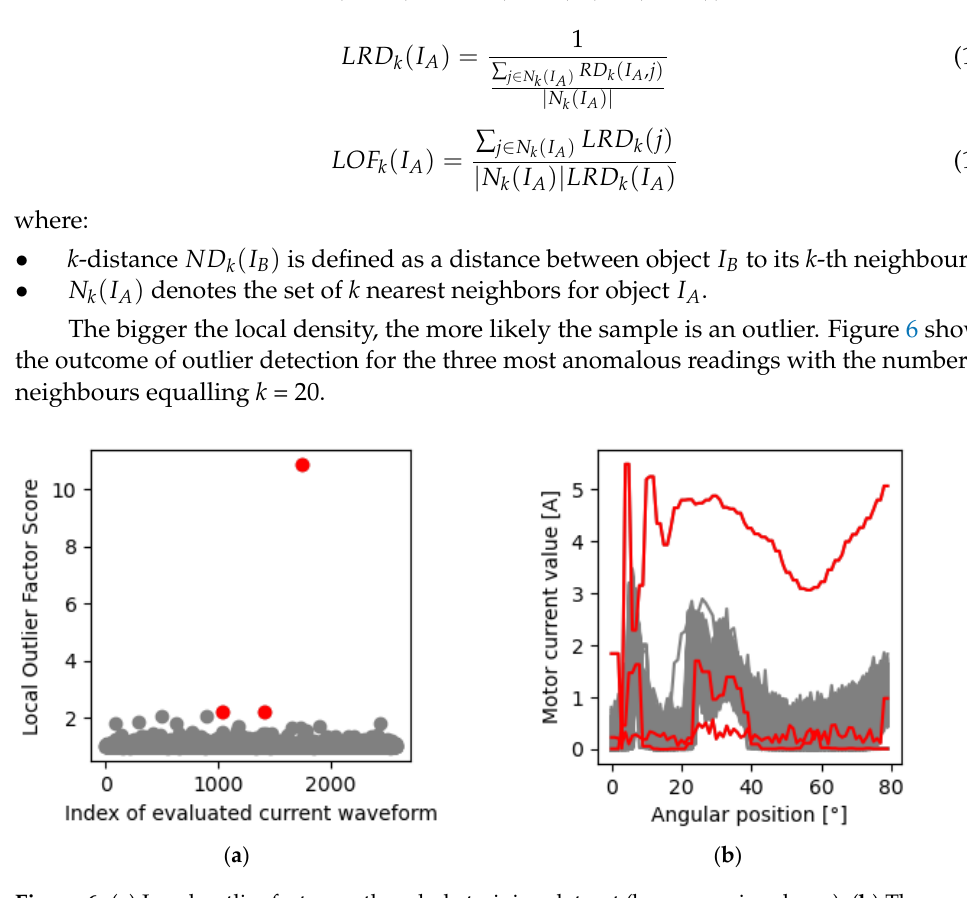
Figure 6. ( a ) Local outlier factor on the whole training dataset (boom moving down); ( b ) Three most anomalous waveforms (red) among the whole training dataset (grey).